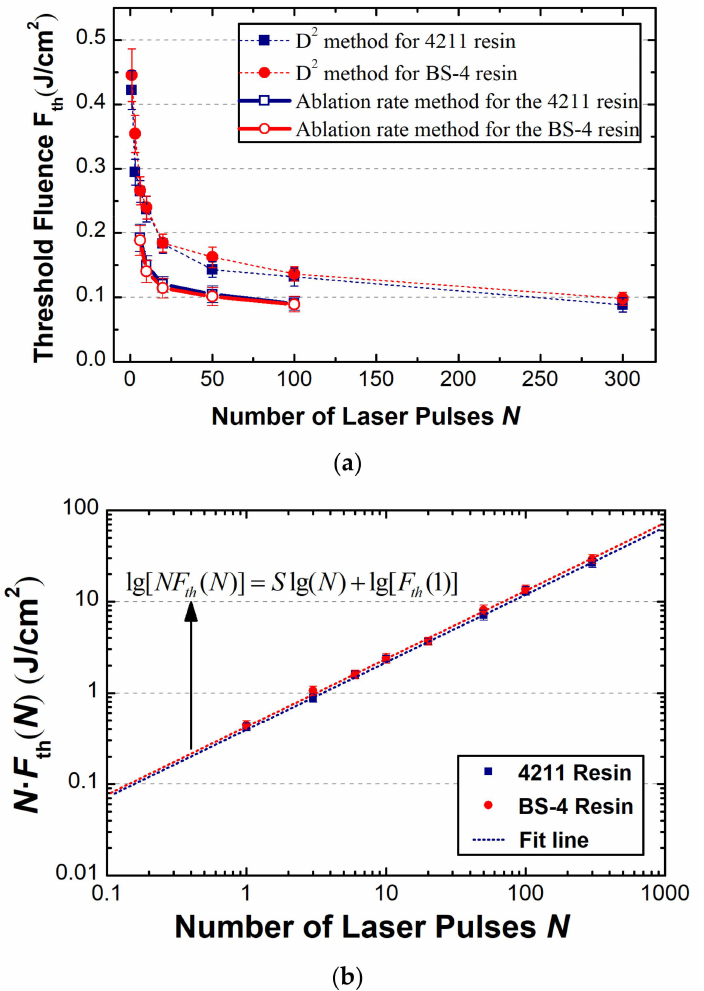
Figure 7. ( a ) Ablation threshold vs. pulse number, namely, incubation behaviors for ablation threshold via two different techniques for both resins; ( b ) accumulated threshold vs. pulse number for deriving the incubation-model-based parameters, where diameter-regression-based thresholds are